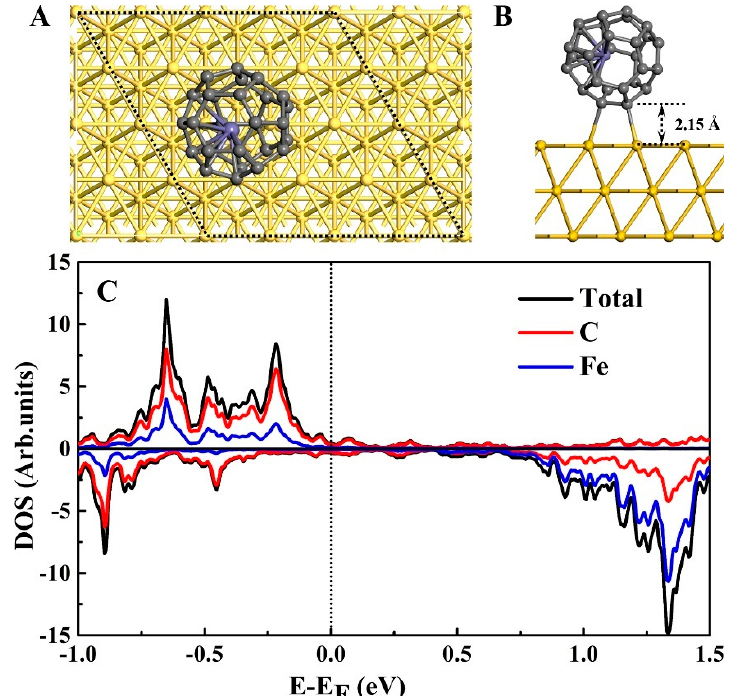
Figure 2. Most stable adsorption configuration. ( A ) Top view. ( B ) Side view. Fe@C 28 is favored and adsorbed on the bridge site of the Au(111) surface via a C–C bond. ( C ) Density of states (DOS)